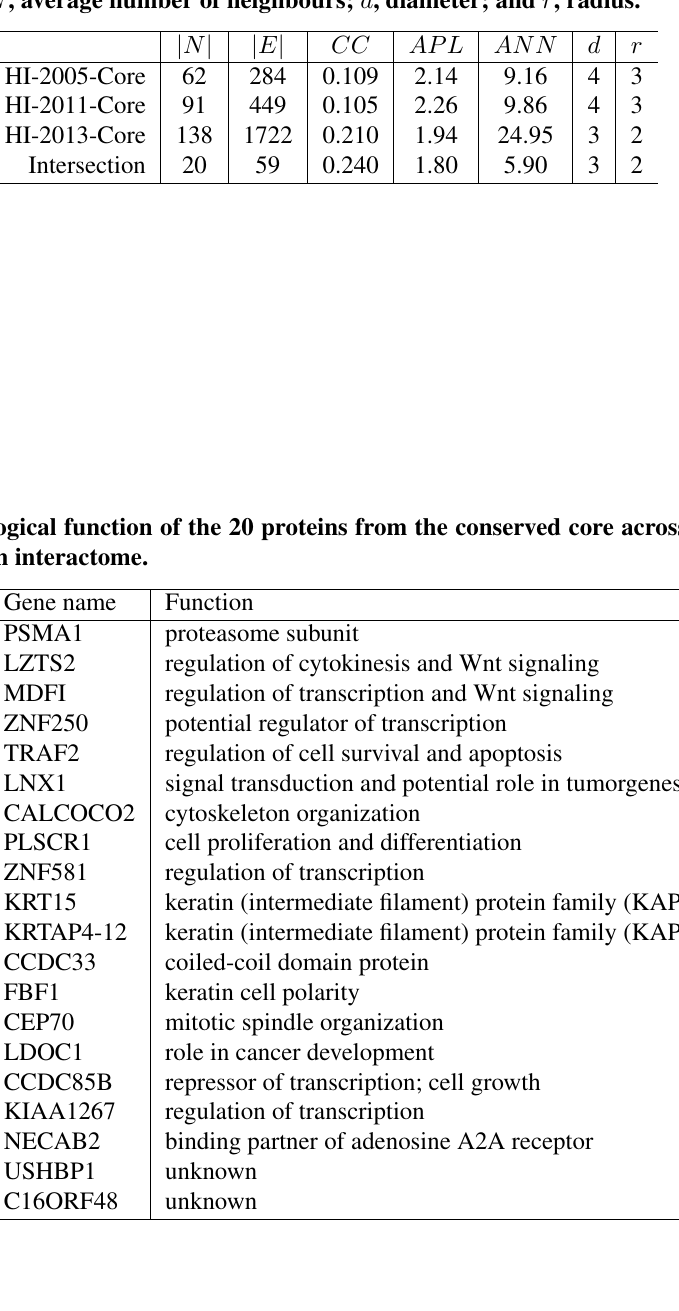
Table 3: Network properties of core sub-networks of HI-2005, HI-2011, HI-2013, and the inter- section of the core sub-networks (i.e., the conserved core sub-graph). The column labels are as follows: | N | , number of nodes; | E | , number of edges; CC , clustering coefficient; APL , avarage path length; ANN , average number of neighbours; d , diameter; and r , radius.